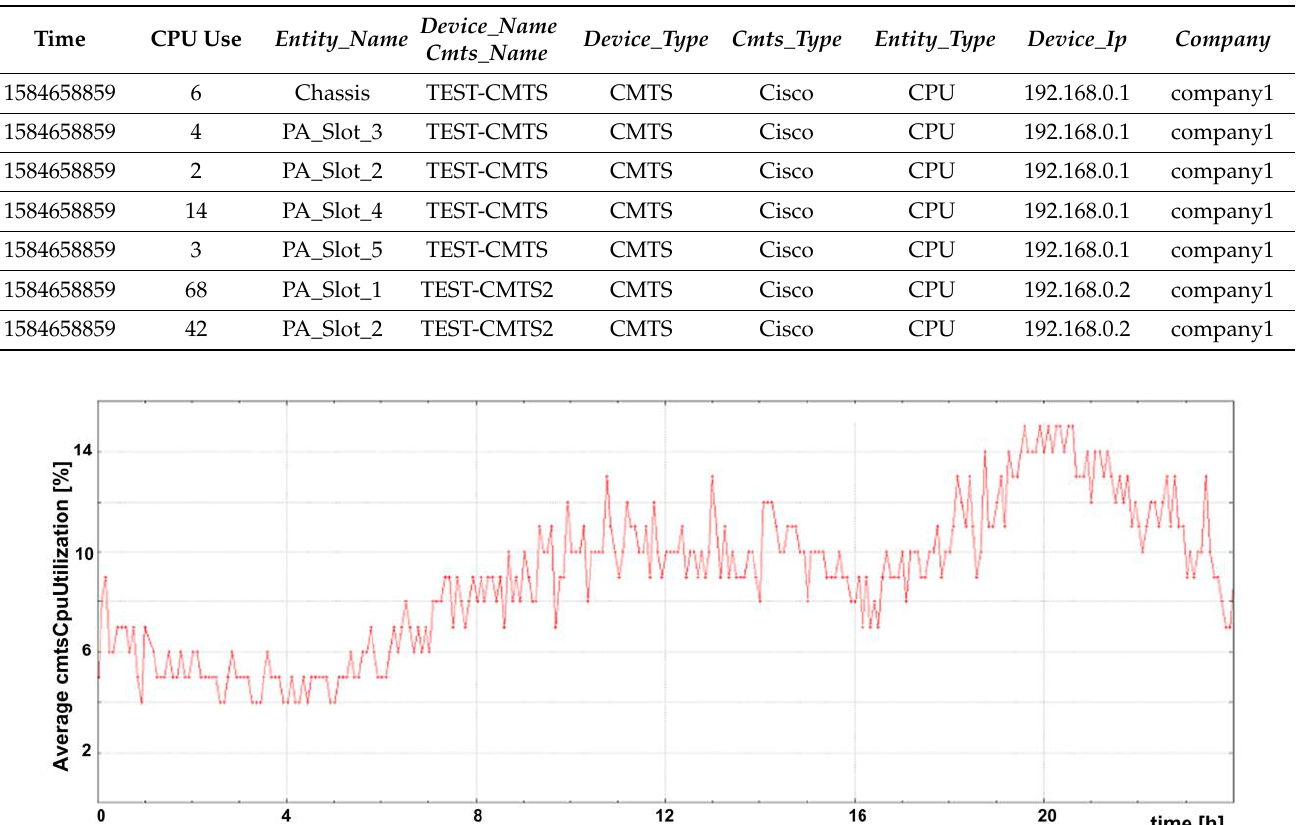
Table 2. Average CMTS CPU utilization ( cmtsCpuUtilisation ).